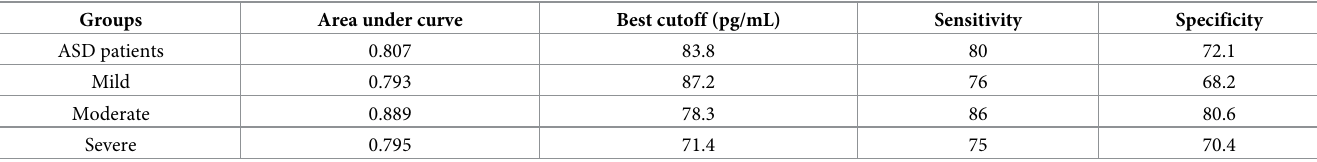
Table 3. ROC analysis.